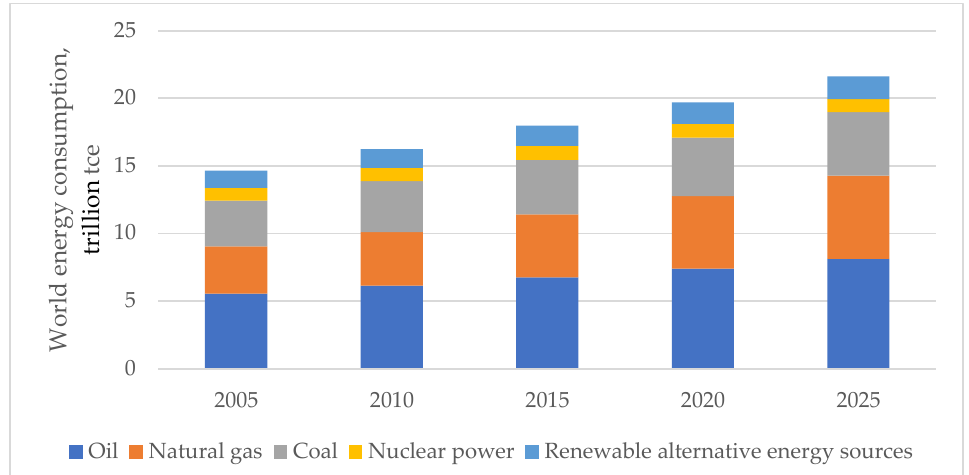
Figure 1. World energy consumption for commercial purposes.